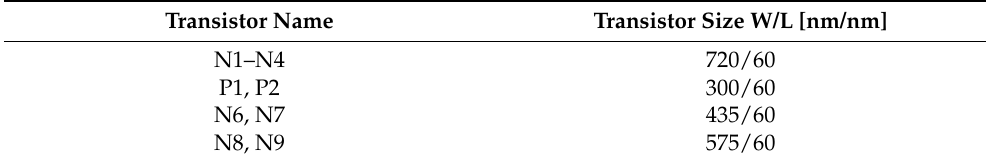
Figure 4. Schematic design of ( a ) SRAM-based BCAM cell; and ( b ) data encoding for write and search [7]. Table 1. Transistor parameters of the complementary metal-oxide-semiconductor (CMOS)-based BCAM